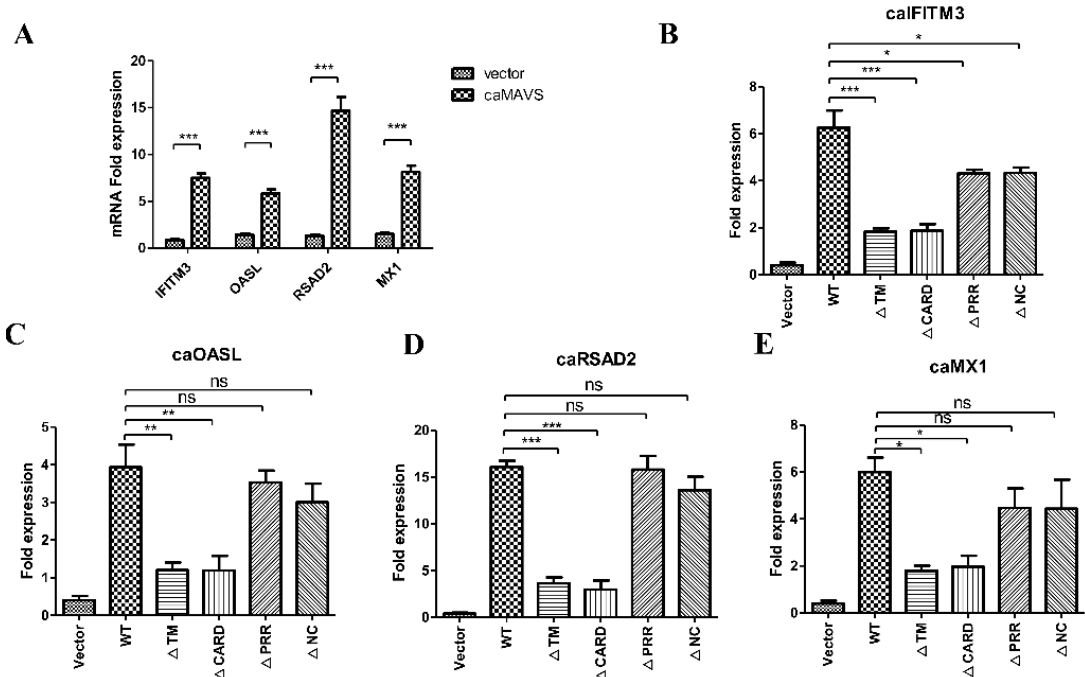
Figure 5. Evaluation of ISGs by overexpression of caMAVS and its mutants in EECs. ( A ) EECs were transfected with either empty vector or caMAVS. The relative mRNA levels of selected caprine ISGs (IFITM3, OASL, RASD2, MX1) were analyzed by qRT-PCR. ( B – E ) EECs were transfected with either empty vector or caMAVS and its mutants. The relative mRNA levels of selected ISGs were analyzed by qRT-PCR. Data presented were from at least three independent experiments. Significance was analyzed by GraphPad prism 5.0 software with a one-way ANOVA test (One-way ANOVA was used for sta- tistical analysis; * p < 0.05; ** p < 0.01; *** p < 0.001).